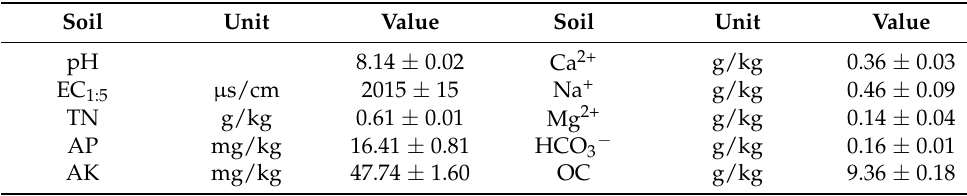
Table 1. Soil characterization in the